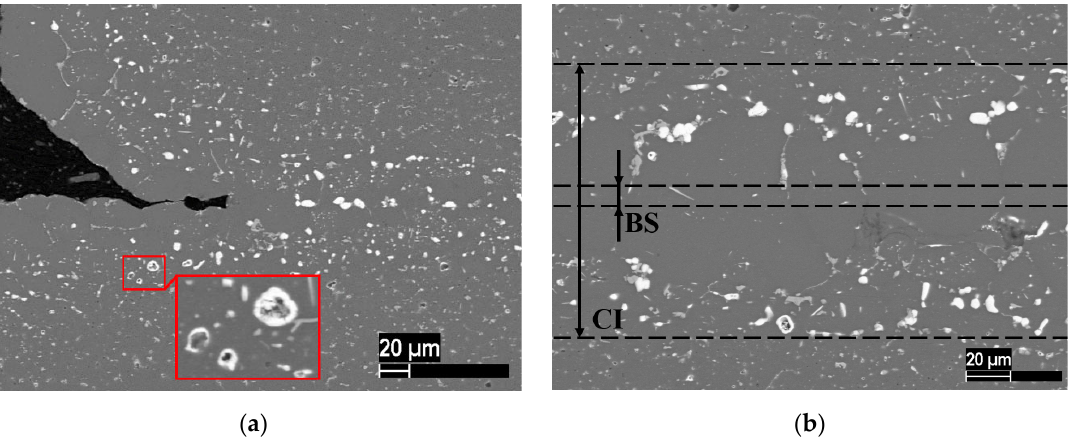
Figure 7. Microstructure of the AA 6082/AA 6082 joint brazed according to the 540 °C/30 min mode, obtained by SEM at different magnifications: ( a ) 250× magnification; ( b ) 500× magnification. The AA 6082/AA 6982 brazed joint microstructure was homogeneous. The AA 6082/AA 6082 brazed seam was characterized by a small thickness ~10 μ m (Figure 7a). No